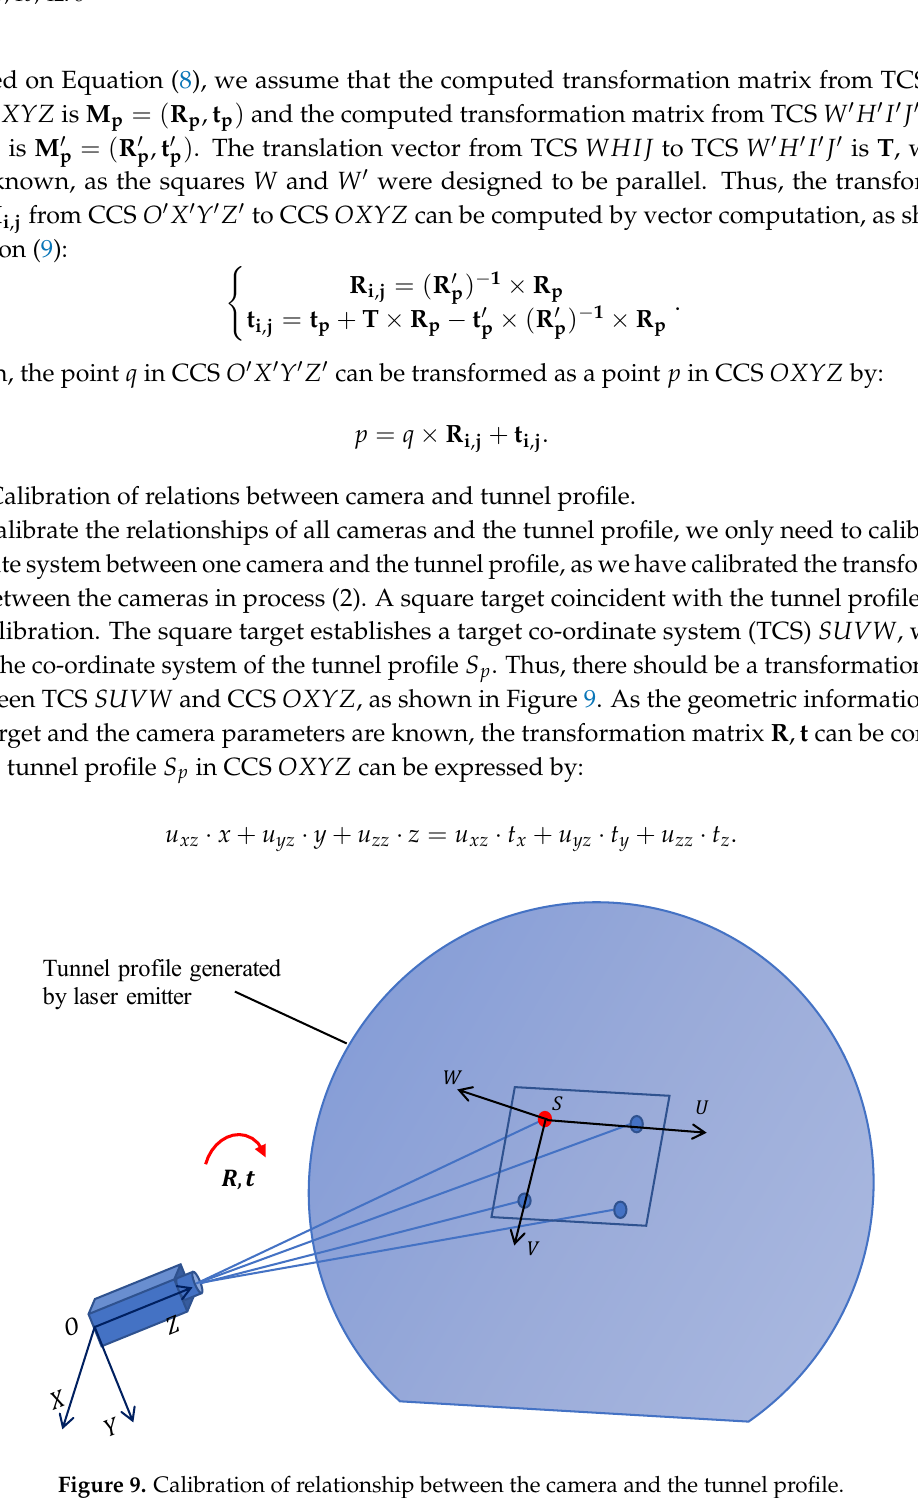
Figure 9. Calibration of relationship between the camera and the tunnel